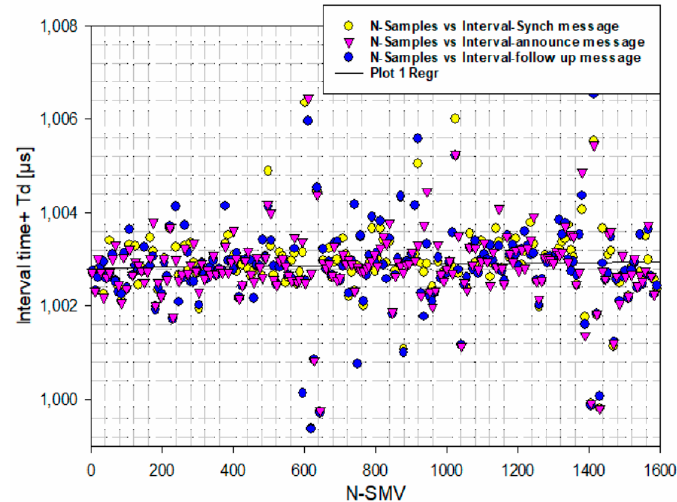
Figure 4. The measured interval time between synchronization announcement messages.